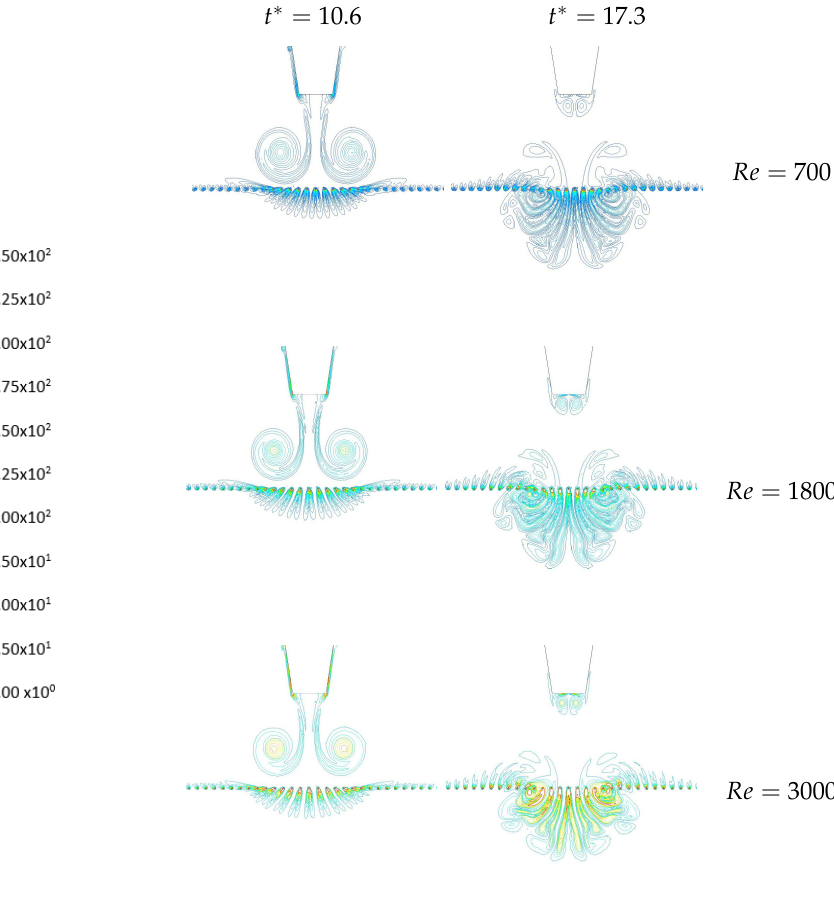
Figure 11. Vorticity contour (1/s) comparison when porosity is 0.8, at t ∗ = 10.6 ( left column ), t ∗ = 17.3 ( right column